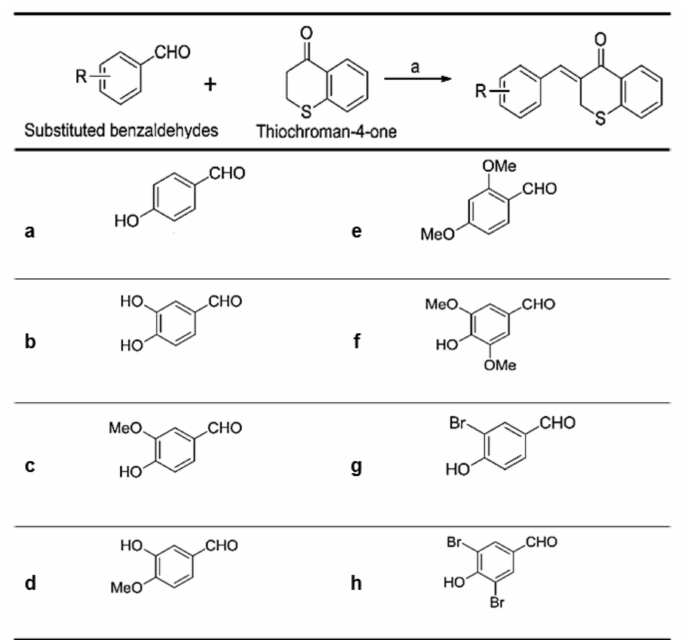
Figure 2. Substitution pattern of the ( Z )-3-(hydroxyl-substituted benzylidene)thiochroman- 4-one